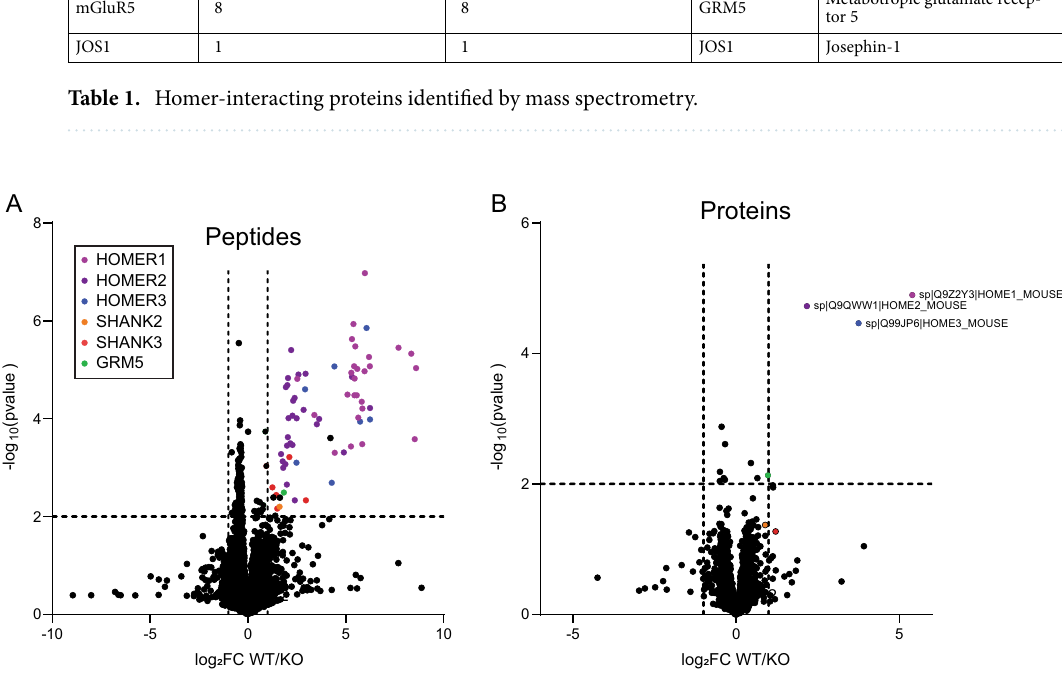
Figure 3. Co-IP’d peptides and proteins identified comparing WT vs KO in the KCl condition. ( A ) Volcano plot showing peptides that were enriched in WT vs KO cortex. Key shows the color-coding of the peptides. ( B ) Volcano plot showing proteins that were enriched in WT vs KO cortex. Enriched proteins are labeled. Comparing to Fig. 2, the loss of GRM5 (green) and Shank2,3 proteins (orange/red) is